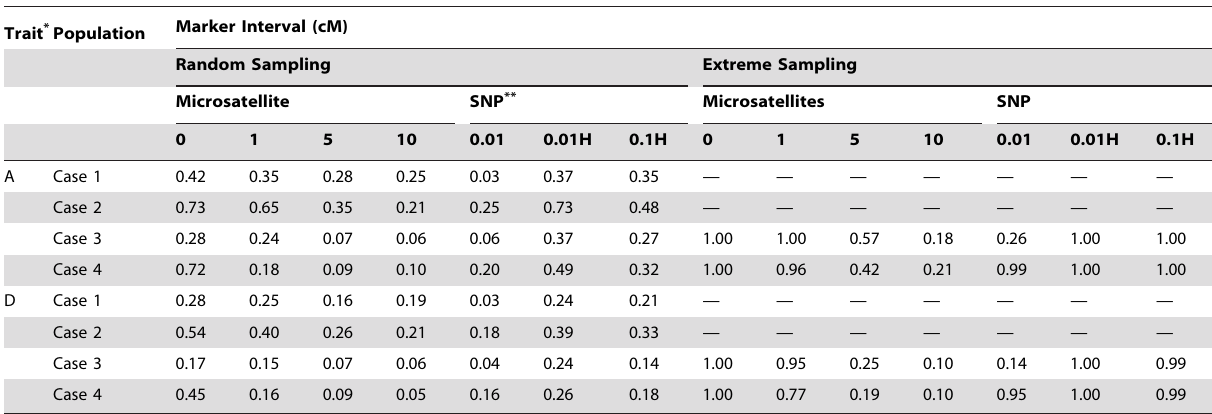
Trait * Population Marker Interval